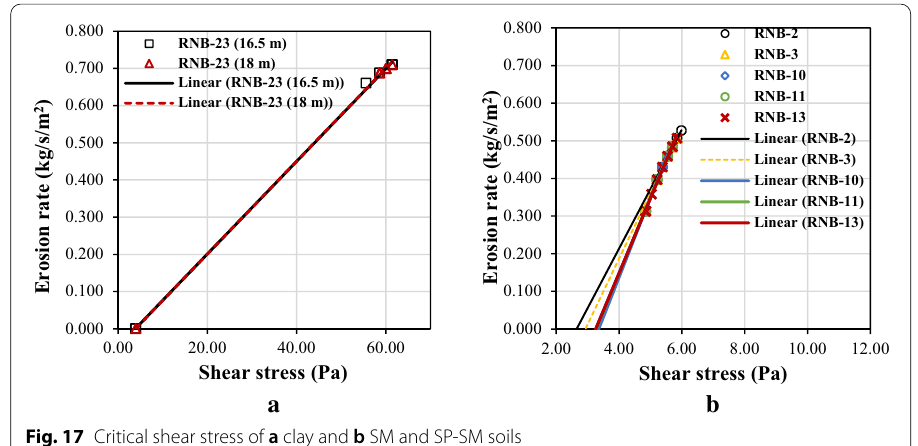
Fig. 17 Critical shear stress of a clay and b SM and SP‑SM soils